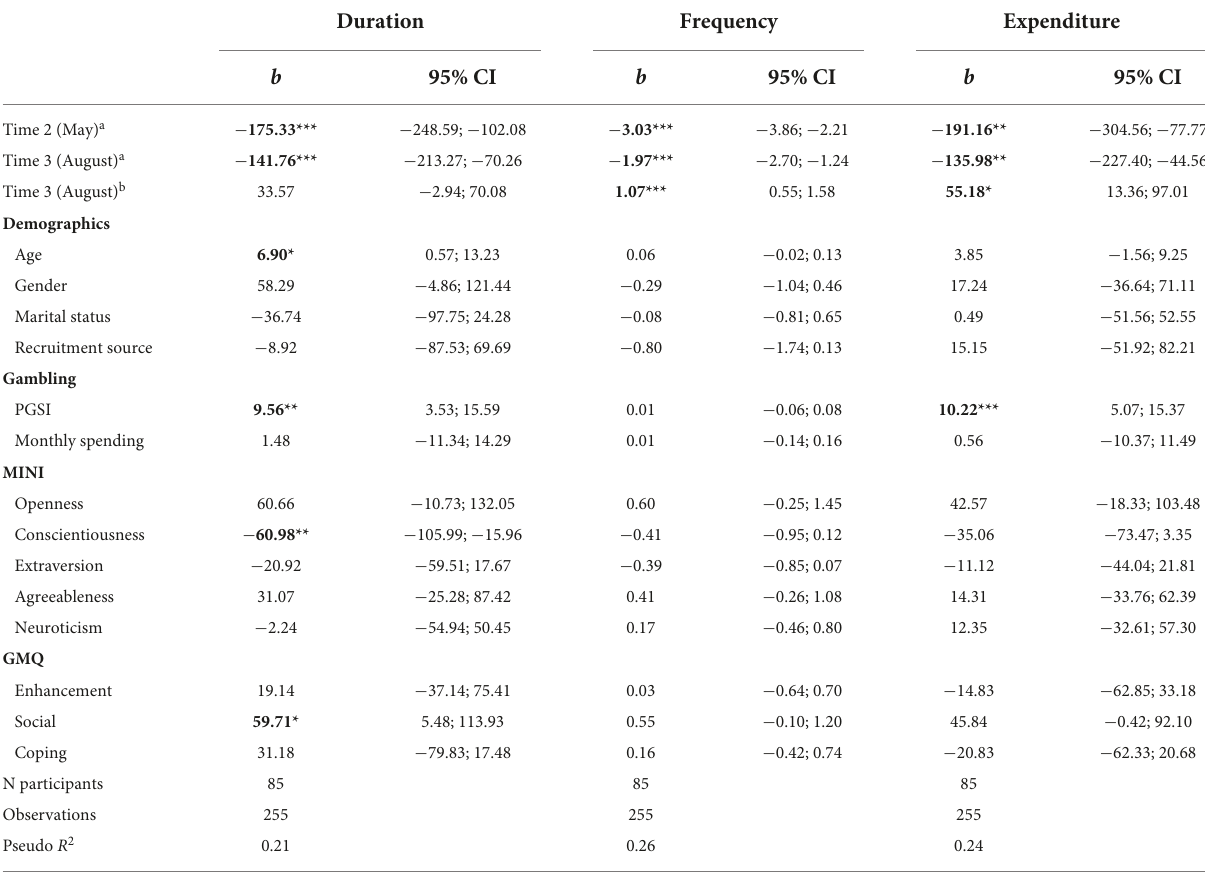
TABLE 2 Linear mixed-model results for overall gambling